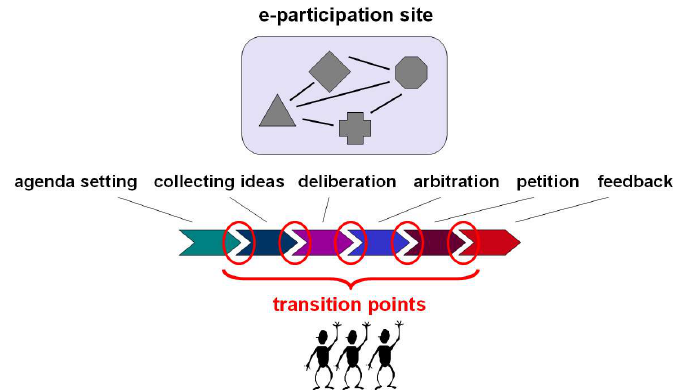
Figure 2: Process support for the phase transitions of an